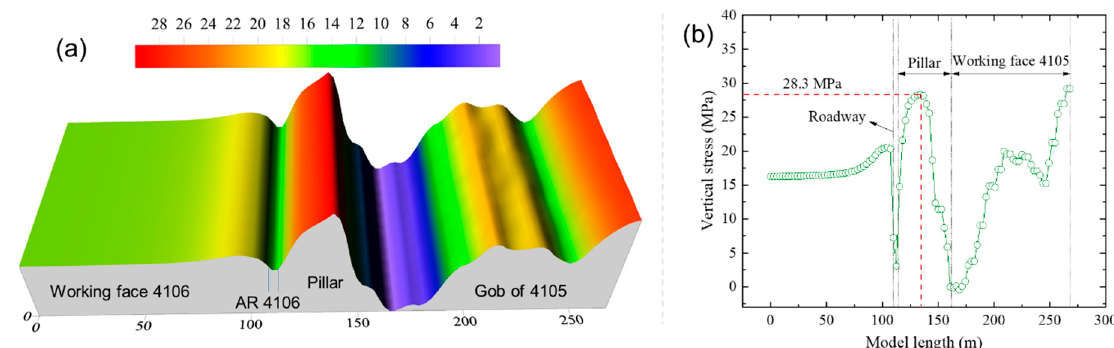
Figure 13. Numerical simulation results: ( a ) stress nephogram of mining numerical simulation at adjacent working face and ( b ) stress nephogram section.